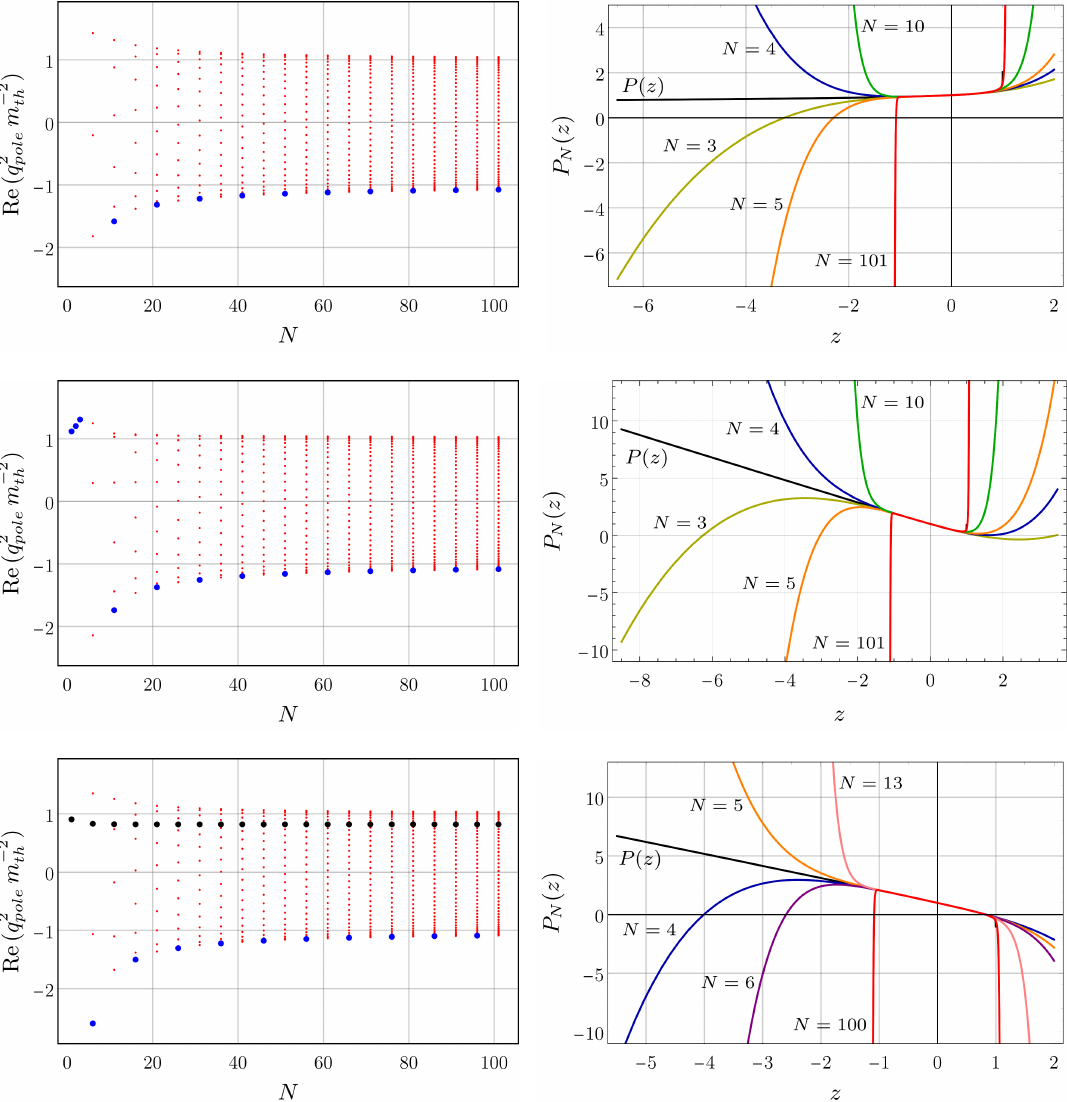
Figure 3 . Pole structure of the truncated propagator (3.13) as function of the truncation order N (figures in the left column) and corresponding truncated P -functions P ( z ) (figures in the right N column) for various N (colorful lines) and in the limiting case N → ∞ (black line). The figures refer to the cases of QED (top panel), Lee-Wick QED (center) and Lee-Wick QED with non-standard coupling (bottom panel). Complex-conjugate poles of the truncated propagator are depicted as small red dots. Blue dots denote real fictitious poles and, in the specific cases analyzed, are generated whenever the corresponding P -function diverges negatively and crosses the z -axis. In the case of N Lee-Wick QED with non-standard coupling (bottom panel) there is an additional real pole (black dot) corresponding to the true (non-fictitious) ghost of the theory. The corresponding (untruncated) P ( z ) -function has indeed a zero at z > 0 in this